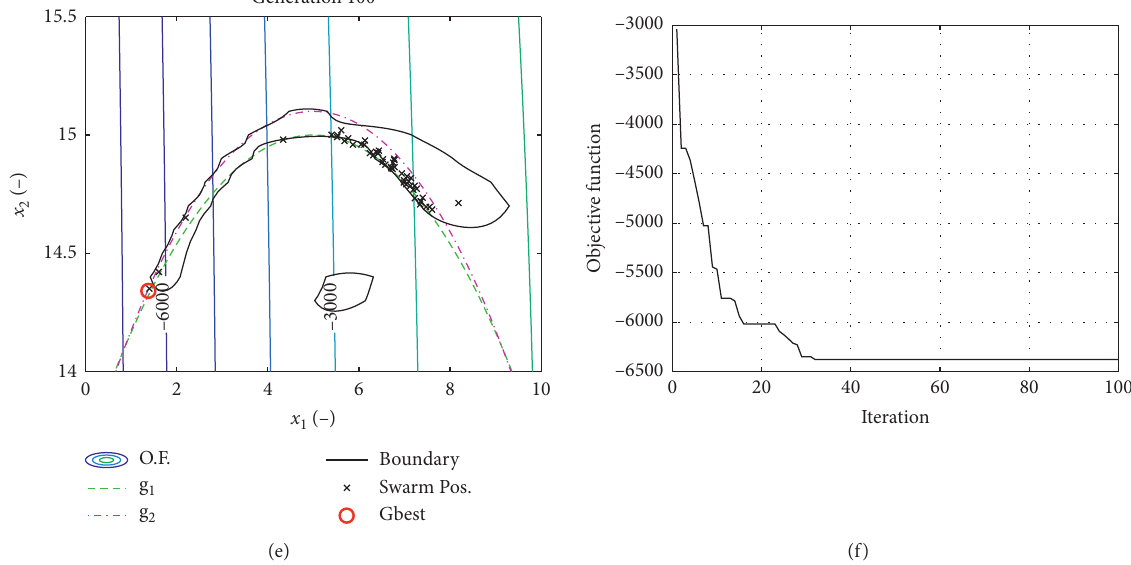
Figure 2: Example 1 (sickle problem [45]): case no relax constraints’ function. (a) 3D graph of sickle problem design space. (b) Generation 1. (c) Generation 2. (d) Generation 50. (e) Generation 100. (f) Objective function